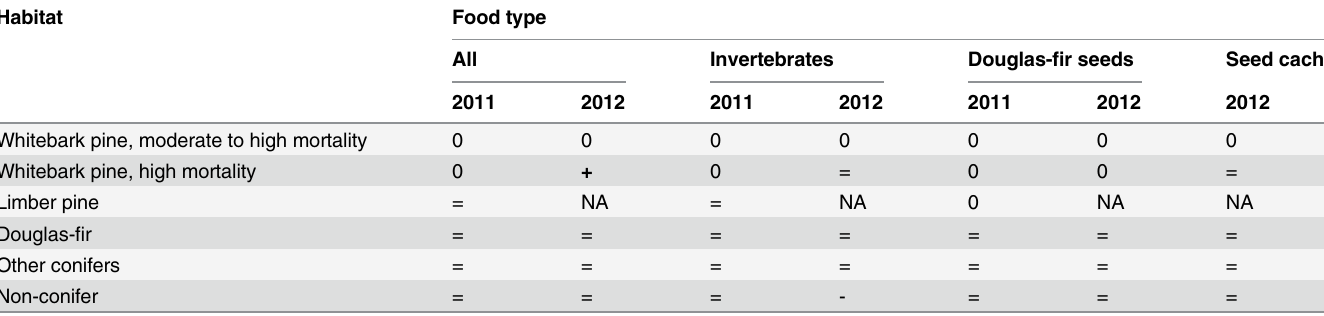
Table 6. Clark ’ s nutcracker foraging habitat selection from within the home range. Habitat